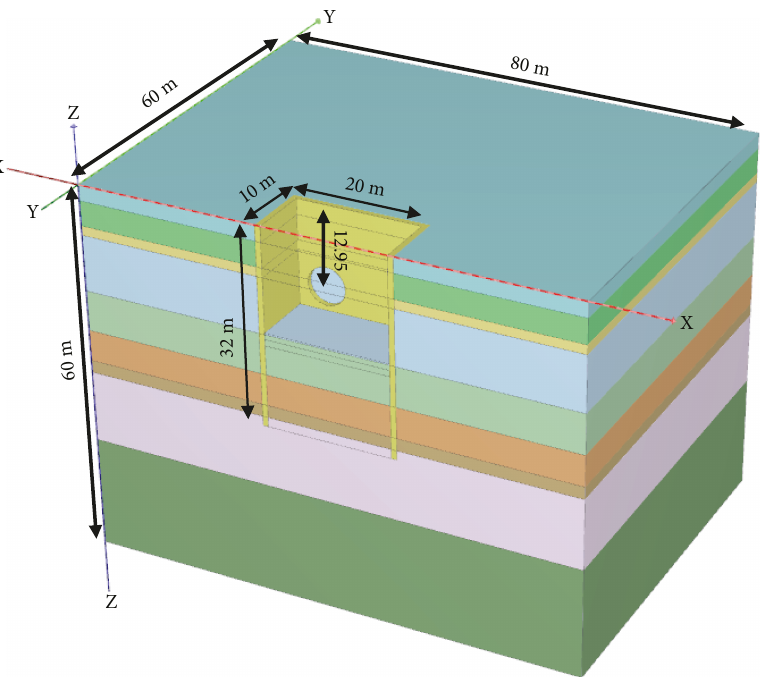
Figure 3: 3-dimensional model of simulation of launching of a